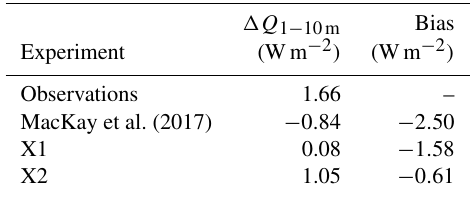
Figure 6. (a) Simulated ice thickness; (b) simulated sediment tem- perature (dotted), lowest-level water temperature (solid), and sed- iment heat flux (dashed – right-hand scale). Simulated results are from experiments X1 (blue) and X2 (red). Zero sediment heat flux (dashed black curve) is also indicated in (b) . The period shown cov- ers 19 July 2013–25 May 2014. Table 2. Observed and simulated change in 1–10m heat content from 26 November 2013 to 6 March